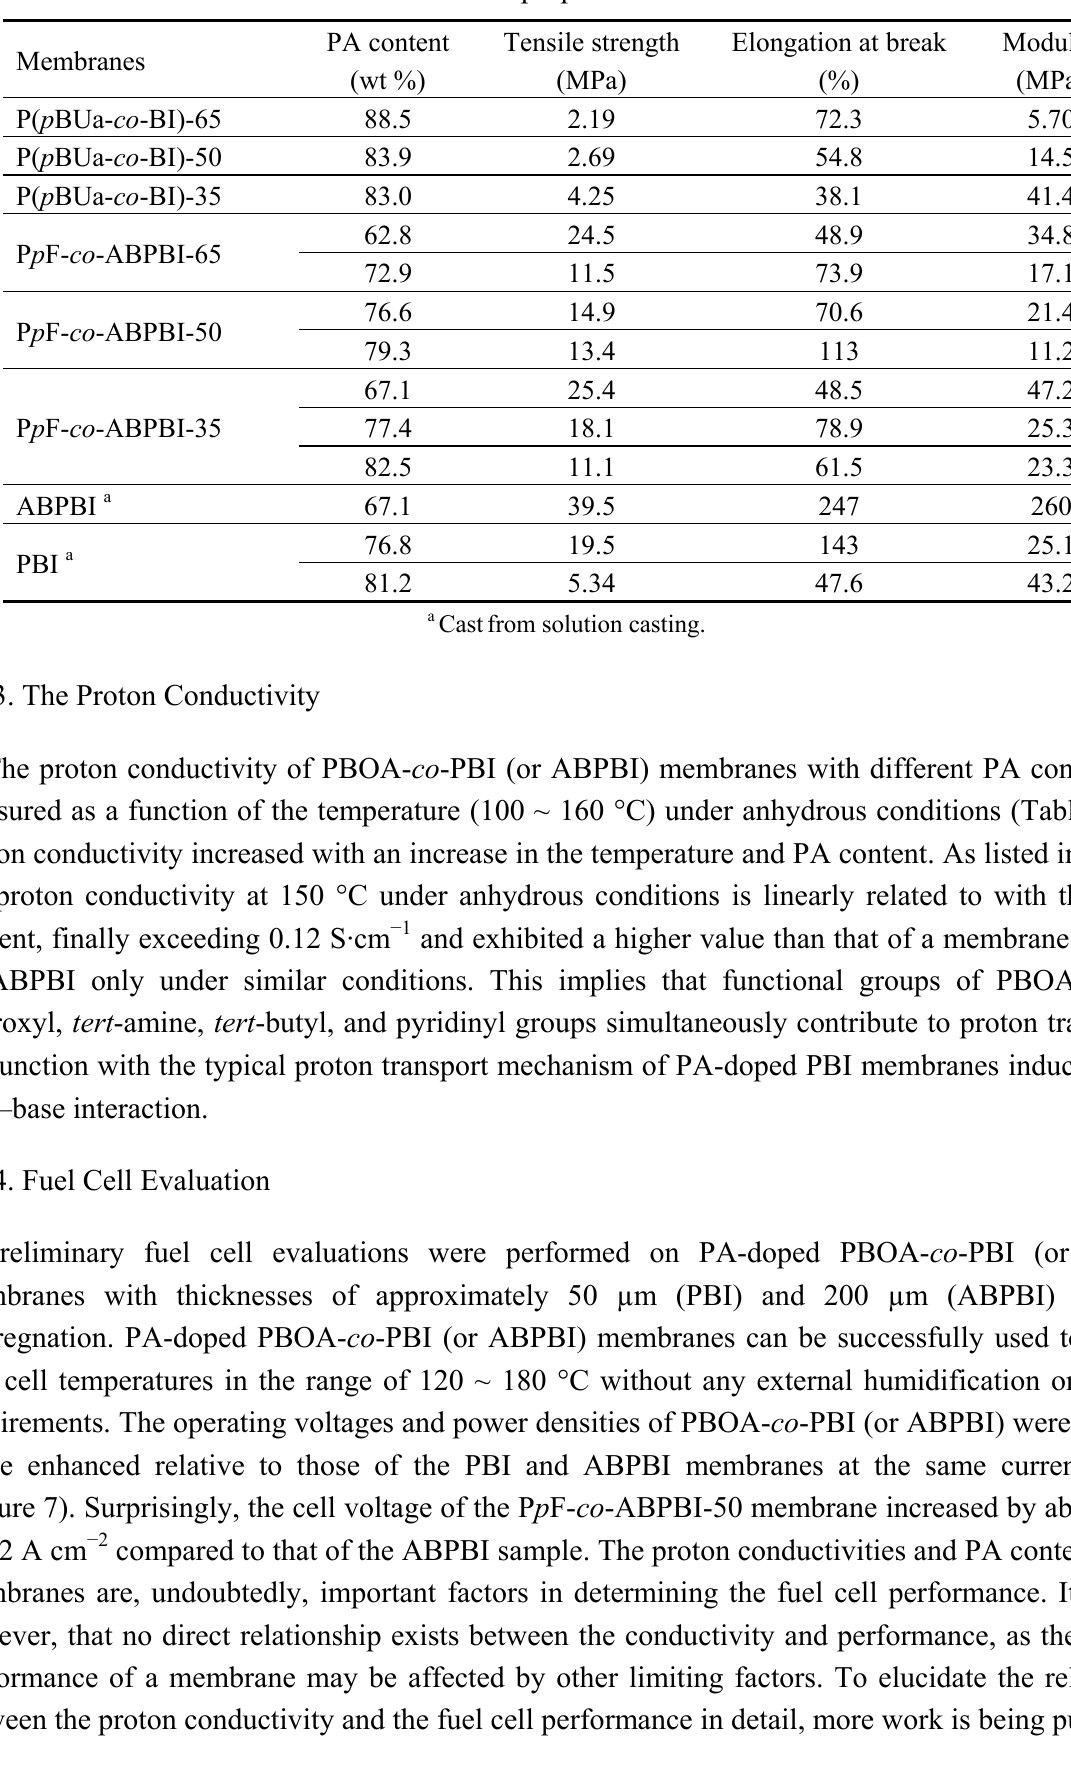
Table 2. Mechanical properties of the